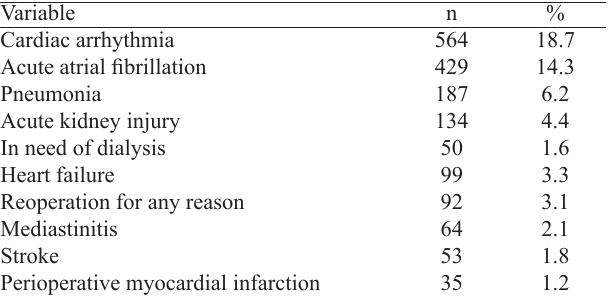
Table 4. Main postoperative complications of 3010 patients who underwent coronary artery bypass grafting, São Paulo, 2010.